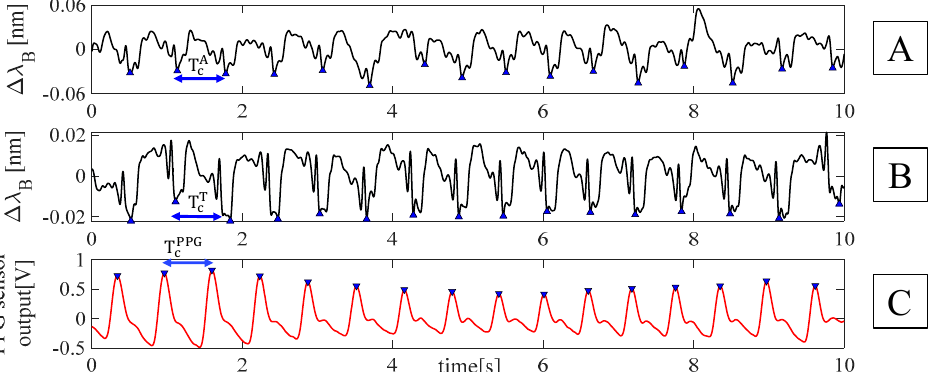
Figure 7. Peaks detection on the filtered signal: ( A ) filtered output changes of FBG A , ( B ) filtered output changes of FBG T , and ( C ) filtered output changes of PPG sensor. The cardiac periods for the band around the abdomen (i.e., T C A ), around the thorax (i.e., T C T ), and for the flow sensor (i.e., T C PPG ) were also reported.